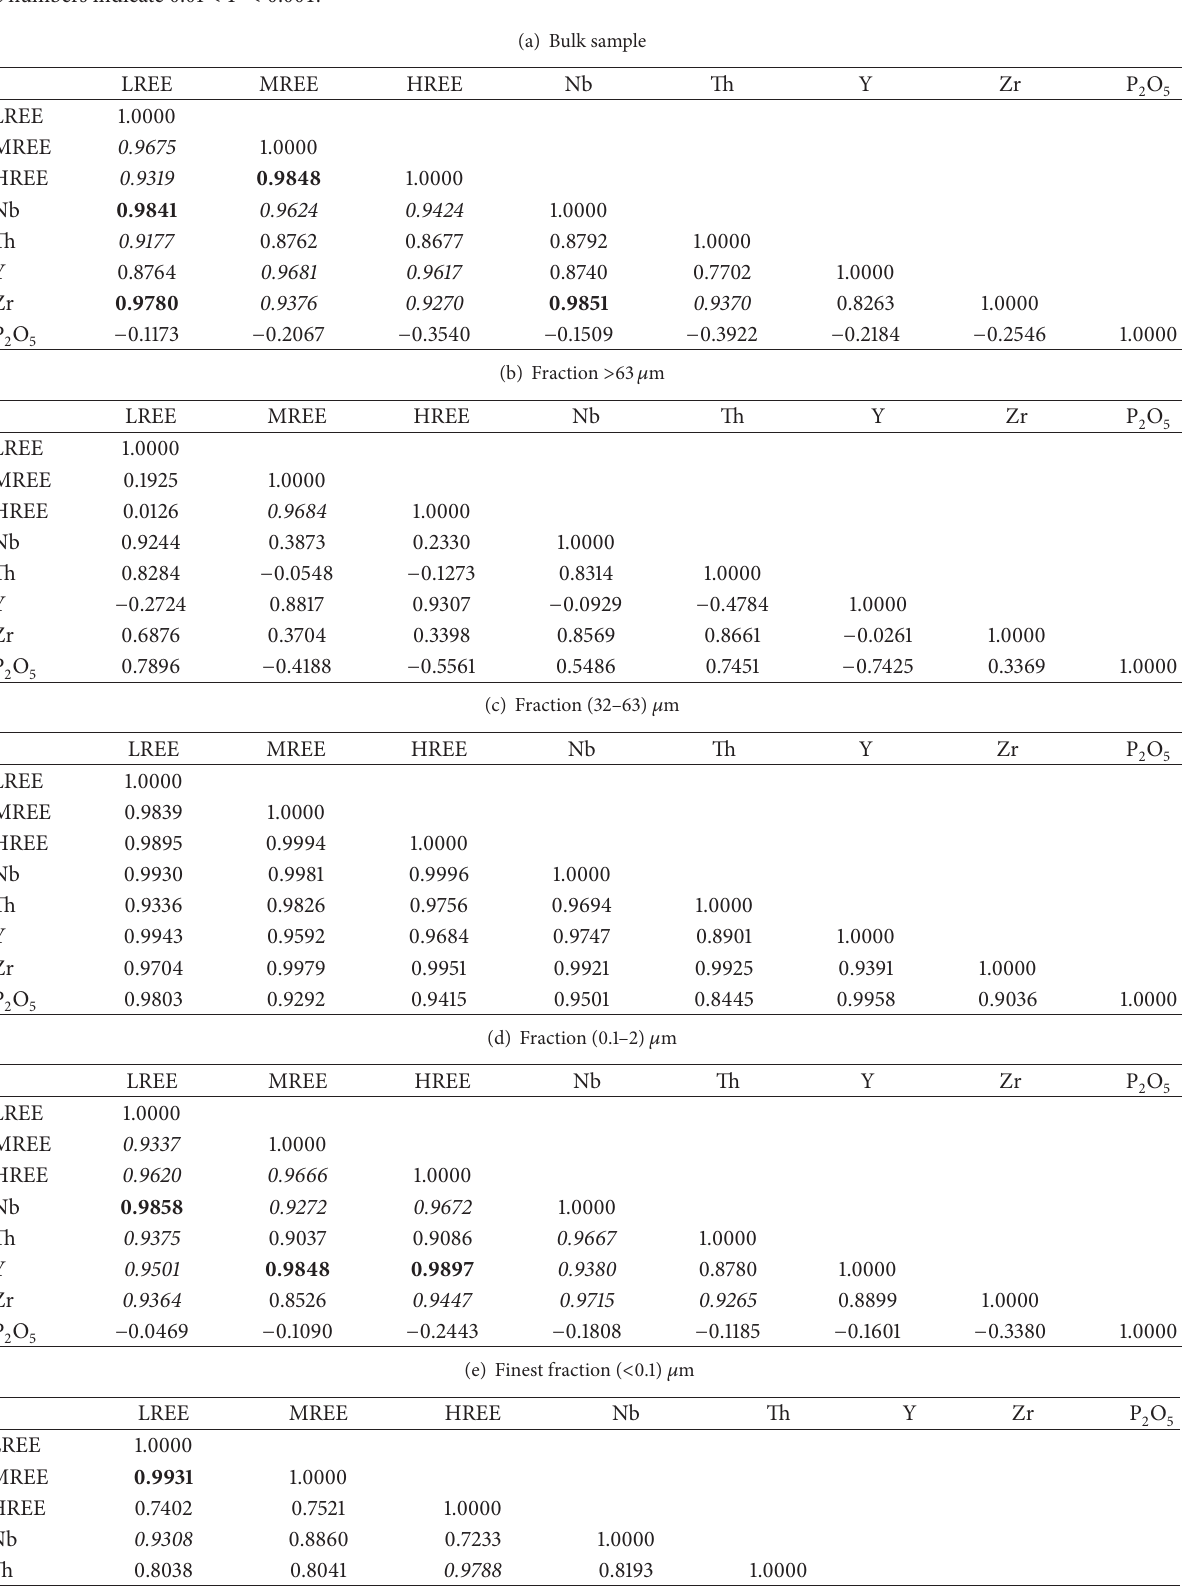
Table 5: Correlation matrix for same elements. LREE = (La-Nd); MREE = (Sm-Tb); HREE = (Dy-Lu). Bold numbers indicate 𝑃 > 0.001 ; italic numbers indicate 0.01 < 𝑃 < 0.001